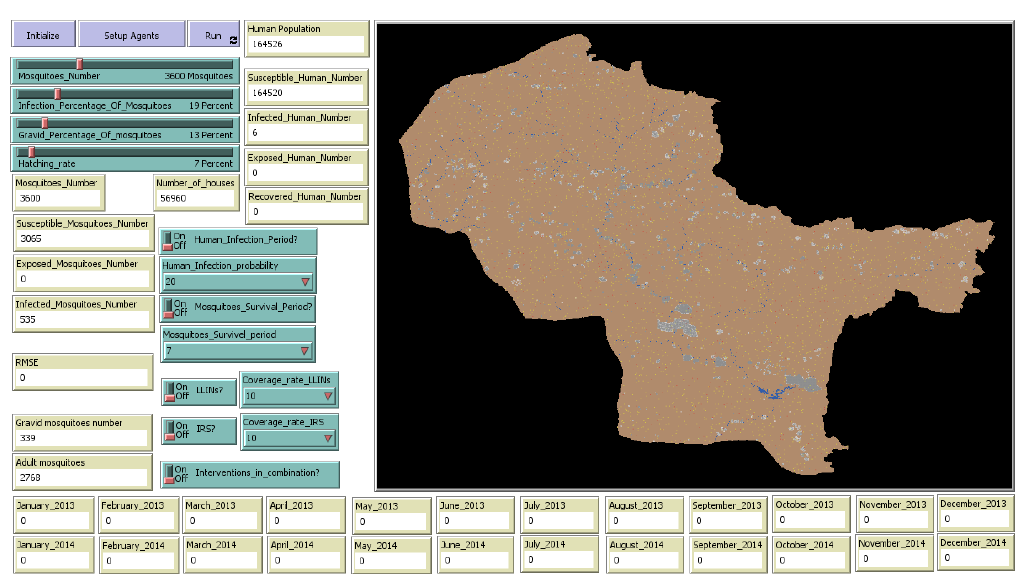
Figure 2. The developed agent-based model in NetLogo 6.0.4.